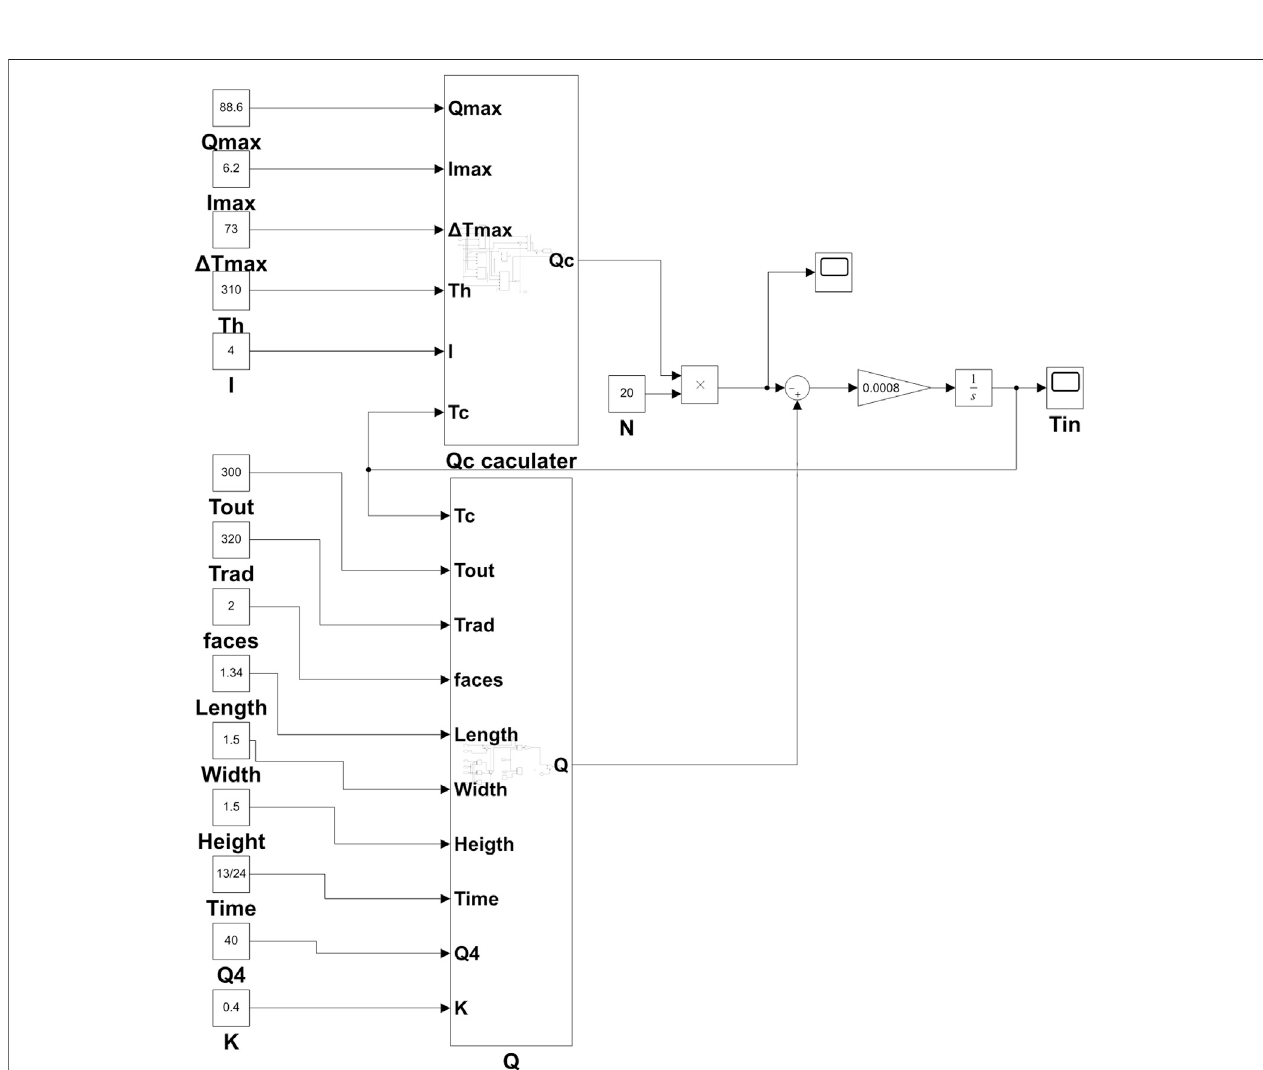
FIGURE 2 | Thermal equilibrium.